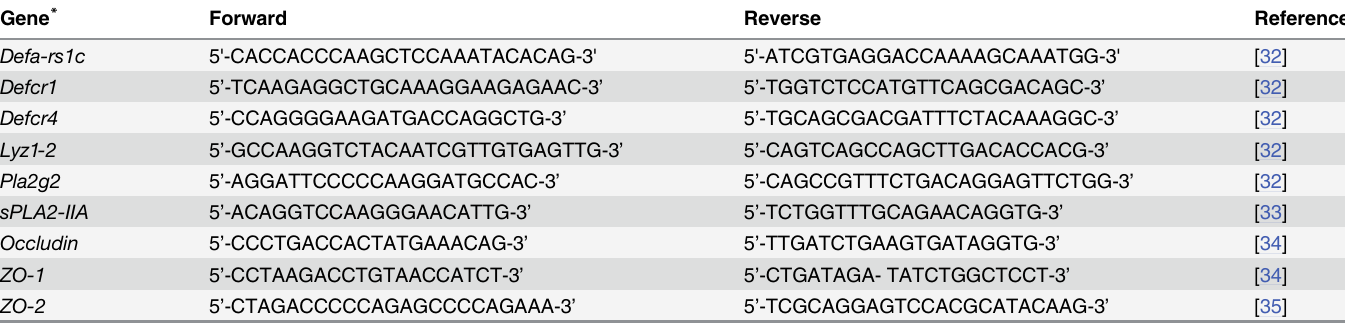
Table 1. Primers used in qPCR